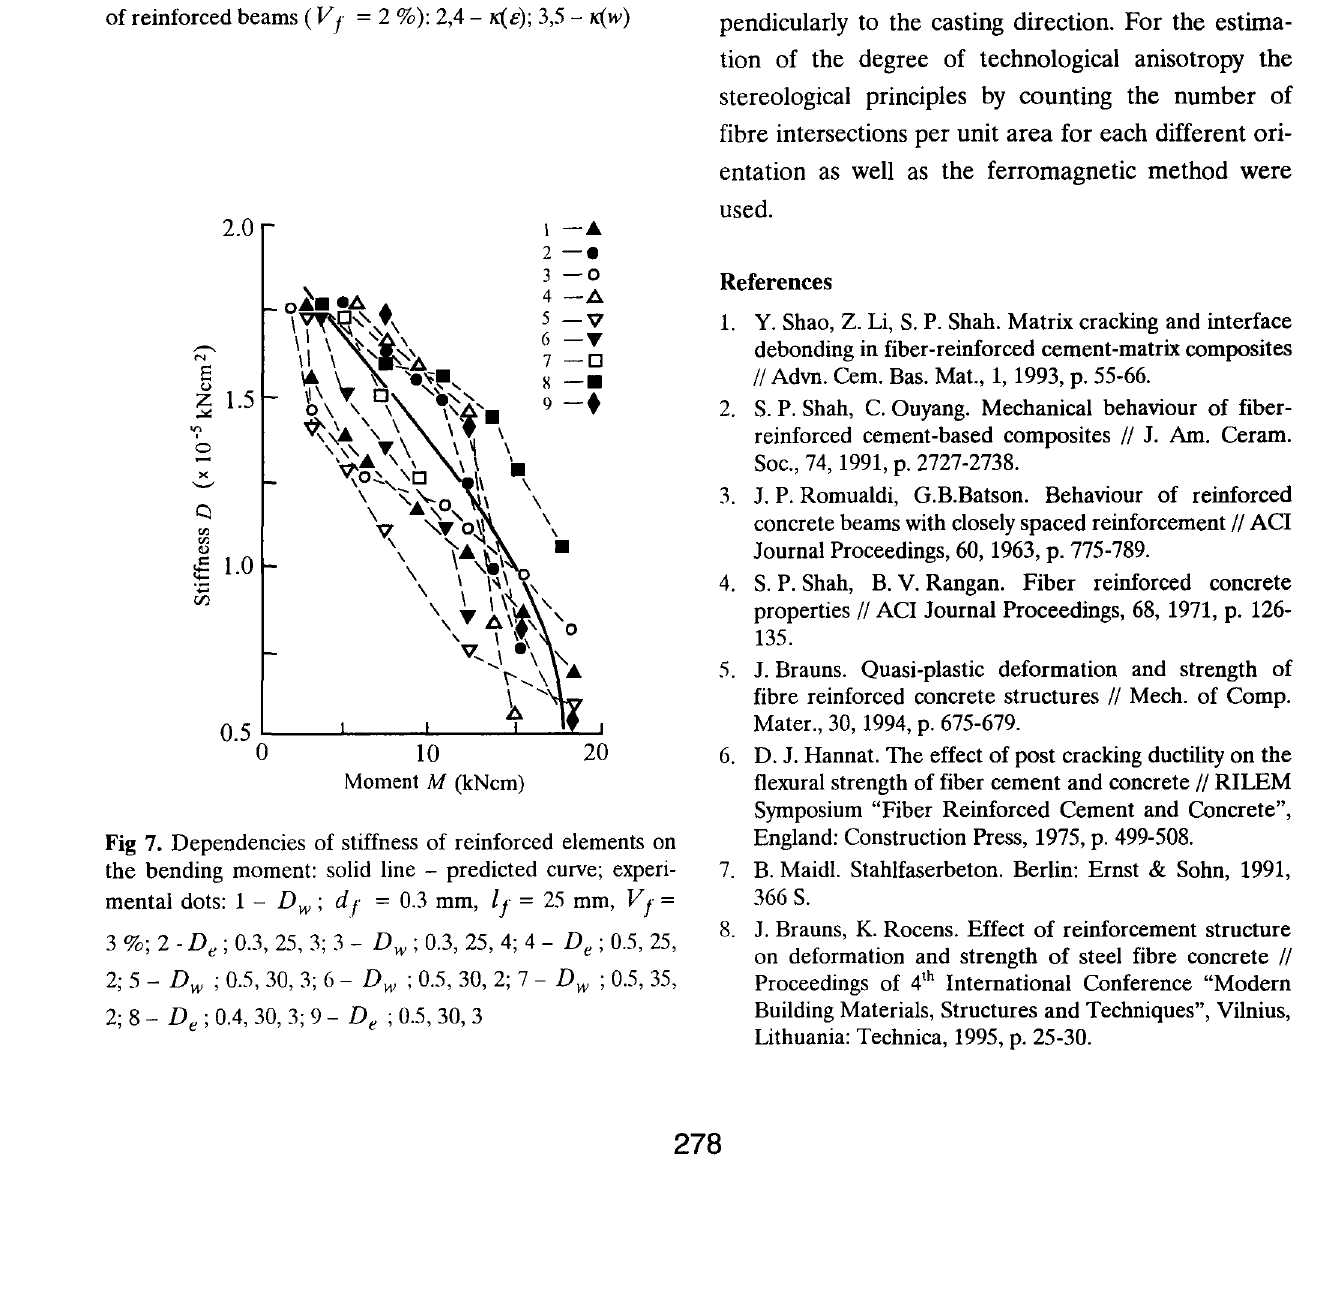
Fig 6. Theoretical (1) and experimental (2-5) bending curves of reinforced beams (Vr = 2 %): 2,4- K(e); 3,5- K(w)